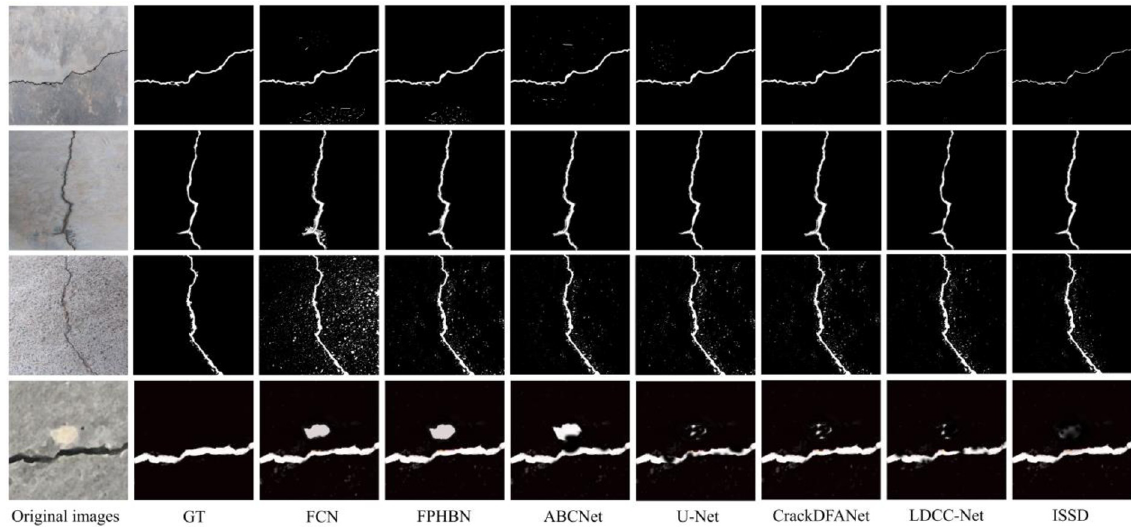
Fig 10. Visualization of detection results of compared networks on the WCD dataset.